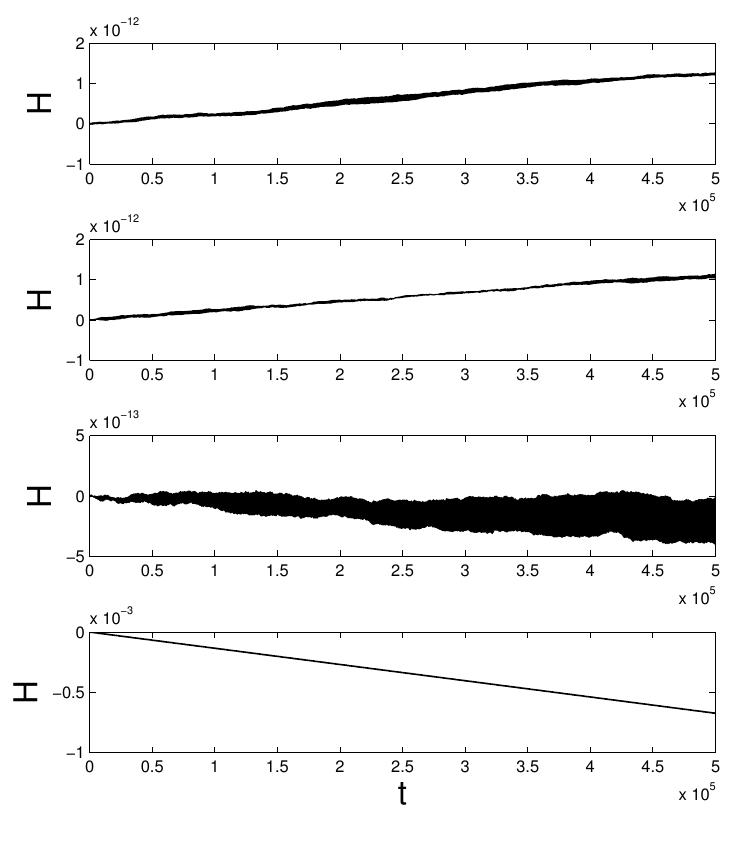
Figure 7. Hamiltonian for the 1-stage ( top ), 2-stage ( second ) and 3-stage ( third ) Gauss, and the 3-stage Radau IIA ( bottom ) methods applied to the system of two point vortices with the time step h = 0.1 over the time interval [ 0,5 × 10 5 ]